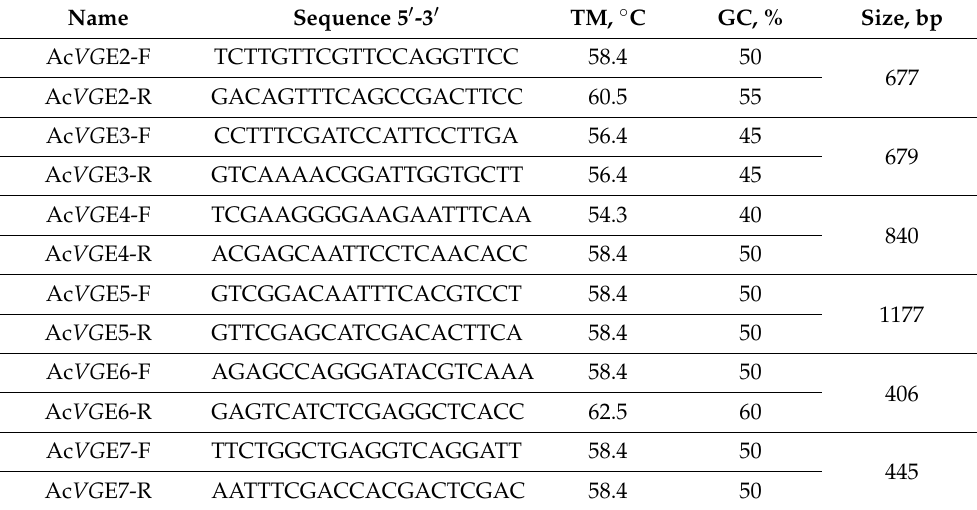
Table 1. PCR primers for the VG gene exons of Apis cerana